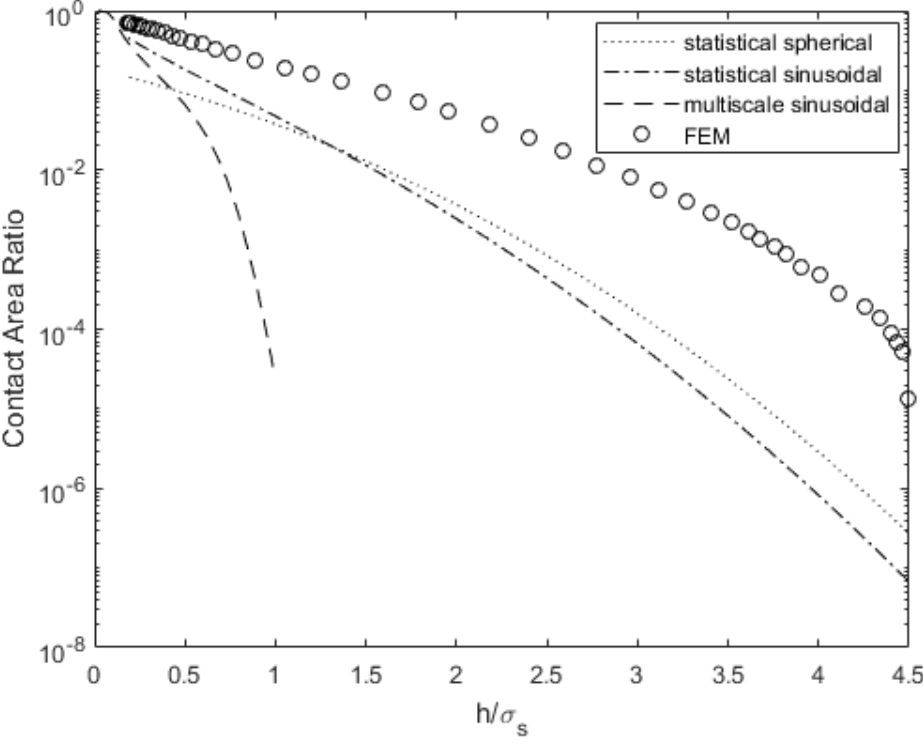
Figure 10. Contact area comparison for varying surface separation for surface 63M.